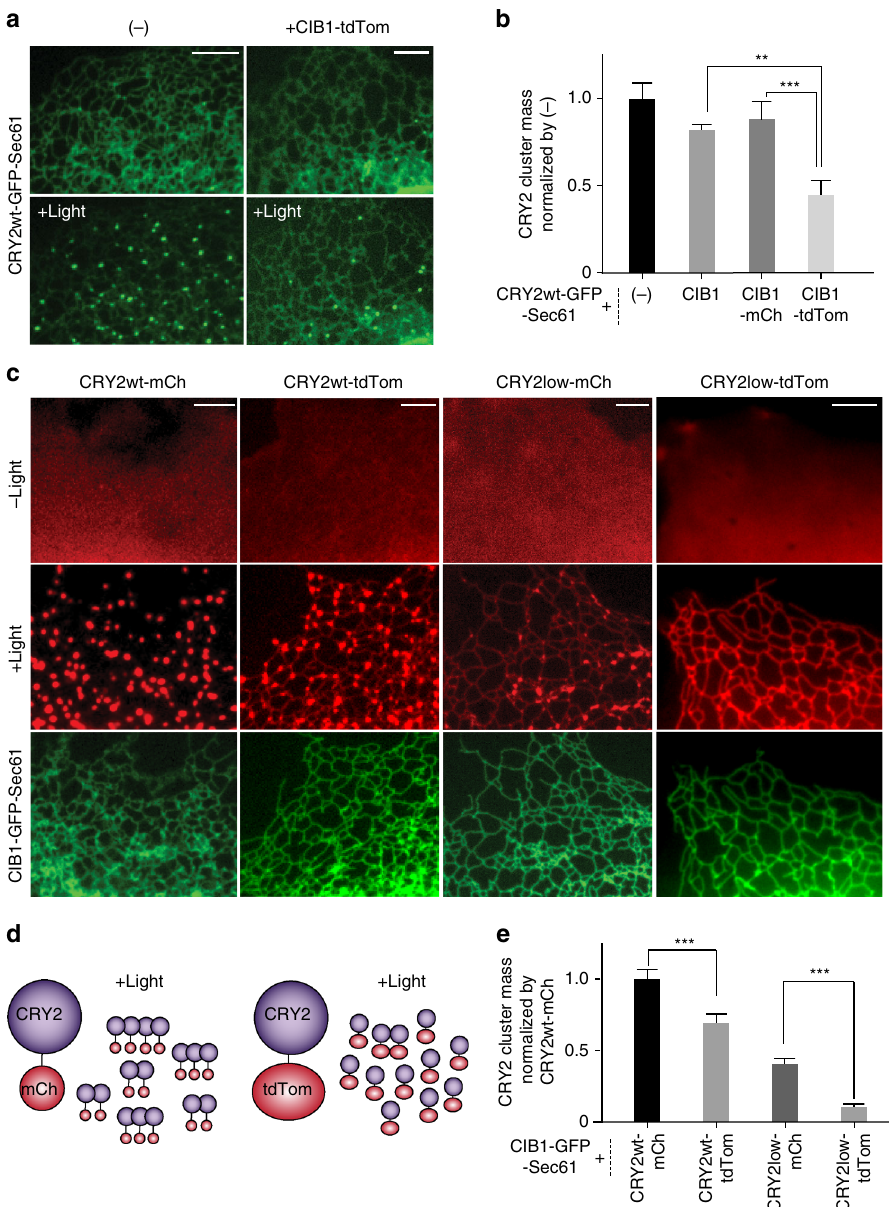
Fig. 4 Fusion with a large fl uorescent protein, tandem dimeric Tomato, further decreases CRY2low homo-oligomerization. Blue light was delivered at 5-s intervals for 100 s ( a , b ) or at 2-s intervals for 20 s ( c , d ). a In cells expressing both CRY2wt-GFP-Sec61 and CIB1-tdTom, blue light induced fewer clusters formation compared to cells expressing only CRY2wt-GFP-Sec61. b Quanti fi cation of the cluster mass of CRY2wt-GFP-Sec61, with or without co- expressing CIB1 fusion proteins, shows that CIB1-tdTom suppresses CRY2 cluster formation. ( n = 11, 16, 11, 10). c After recruitment to the ER membrane via CRY2-CIB1 hetero-dimerization, CRY2wt-tdTom formed fewer clusters than CRY2wt-mCh, and CRY2low-tdTom did not form visible clusters on the ER network. d Illustration of CRY2 homo-oligomerization suppressed by the large protein tdTom. e The cluster mass of CRY2 on ER membrane after recruitment via CRY2 – CIB1 hetero-dimerization was quanti fi ed and normalized against that of CRY2wt-mCh. ( n = 16, 12, 15, 14). Results are presented as means ± s.e.m. and analyzed using one-way ANOVA with Dunnett ’ s post hoc test. (** P < 0.005, *** P < 0.0005). Scale bars , 5 µ